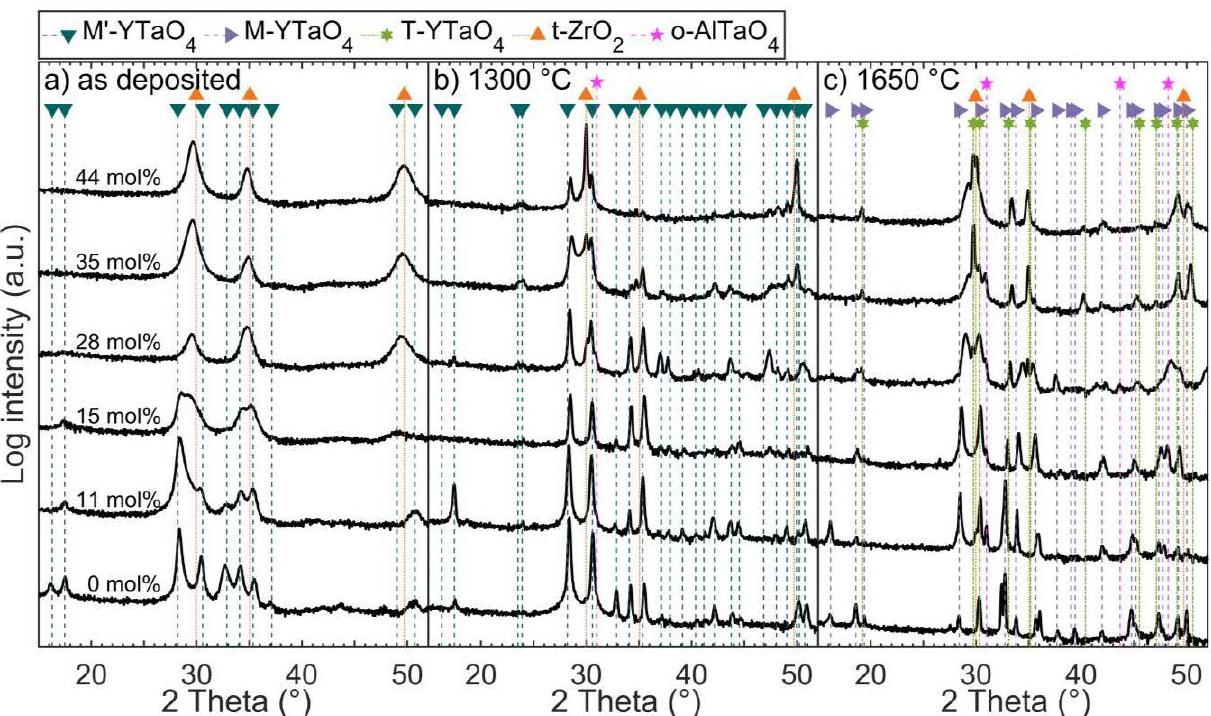
Figure 7. Diffractograms of Y (1 − x)/2 Ta (1 − x)/2 Zr x O 2 coatings with x ranging from 0 to 44 in ( a ) As-deposited, ( b ) Annealed for 1 h at 1300 °C, and ( c ) Annealed for 1 h at 1650 °C states.